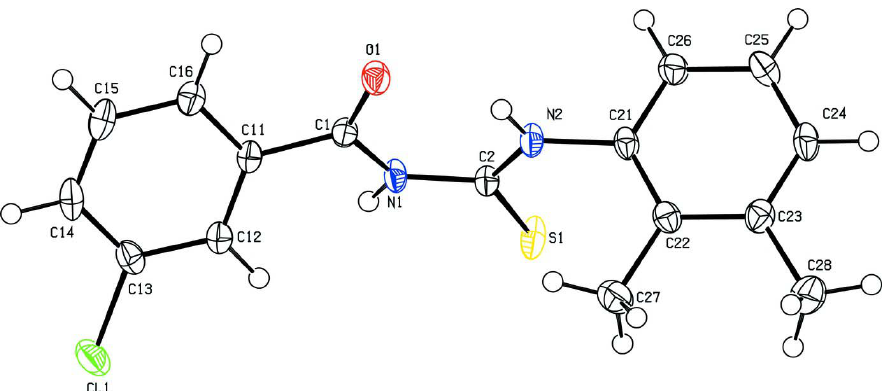
Figure 1 Molecular structure of (I) showing atom numbering scheme. Displacement ellipsoids are drawn at the 50% probability